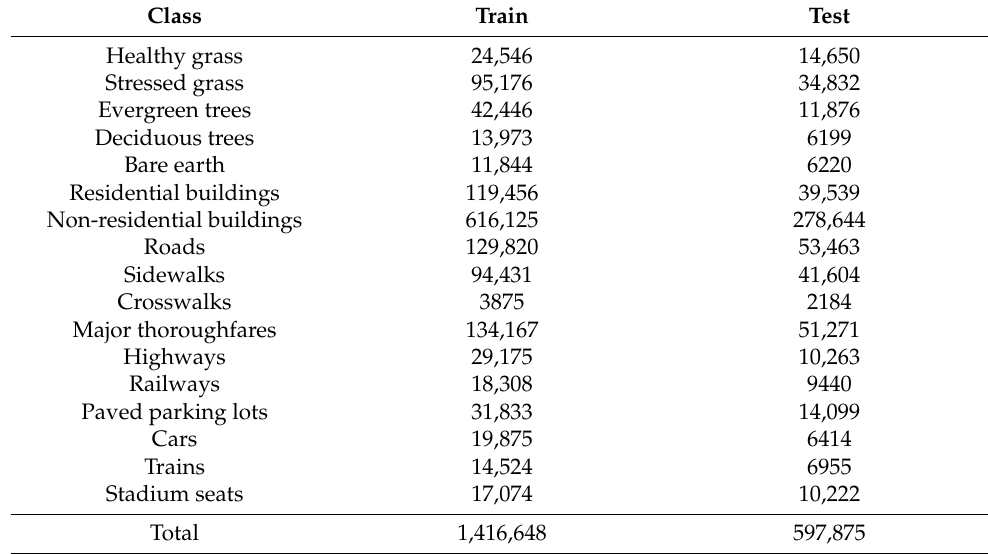
Table 3. Number of samples in train and test sets for the Xiongan datasets. Class